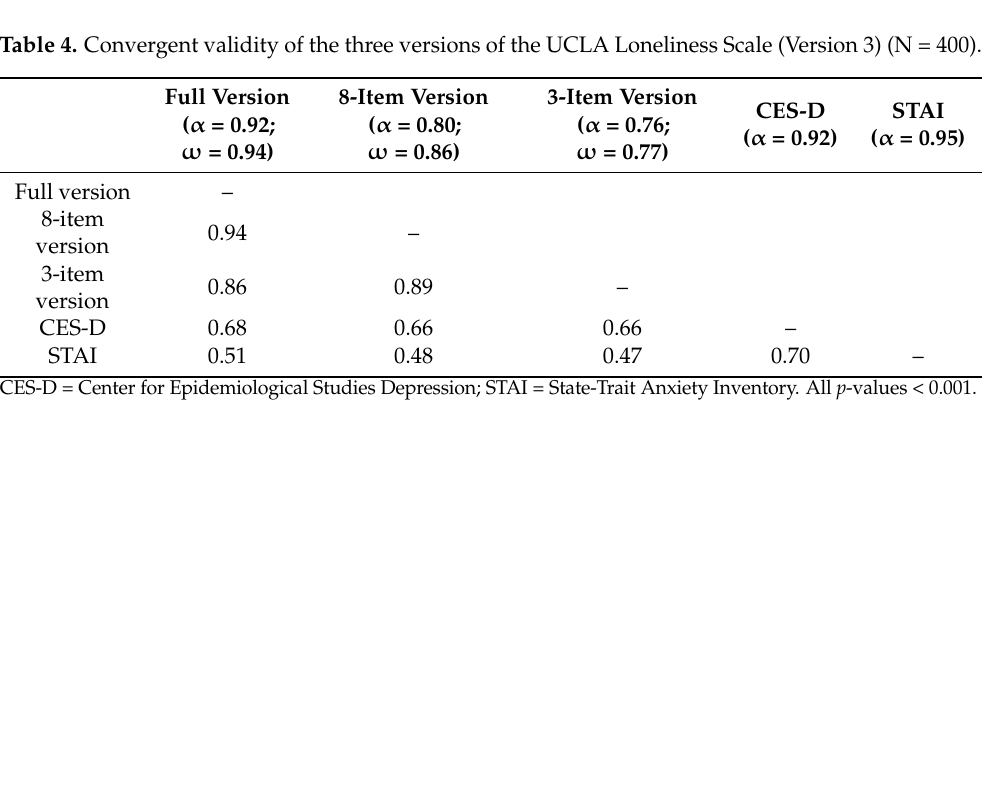
Table 4. Convergent validity of the three versions of the UCLA Loneliness Scale (Version 3) (N = 400).